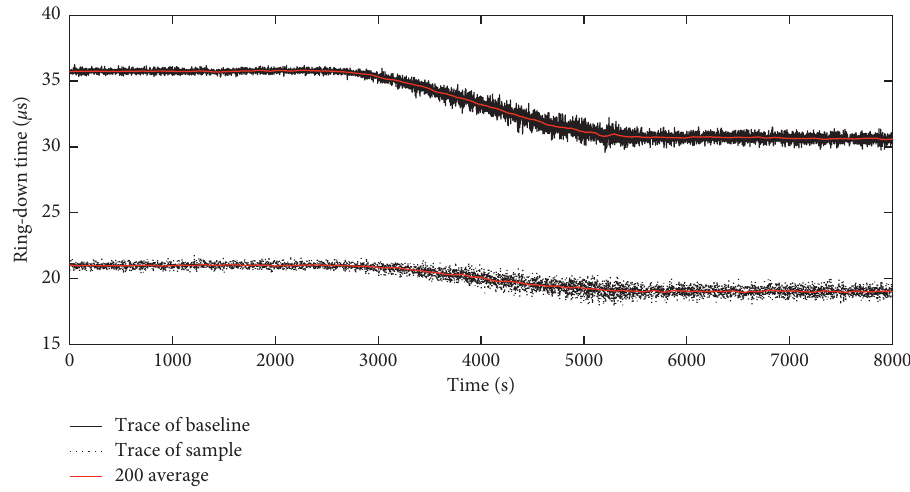
Figure 10: The ring-down time τ and τ 0 acquired by differential measurement method.